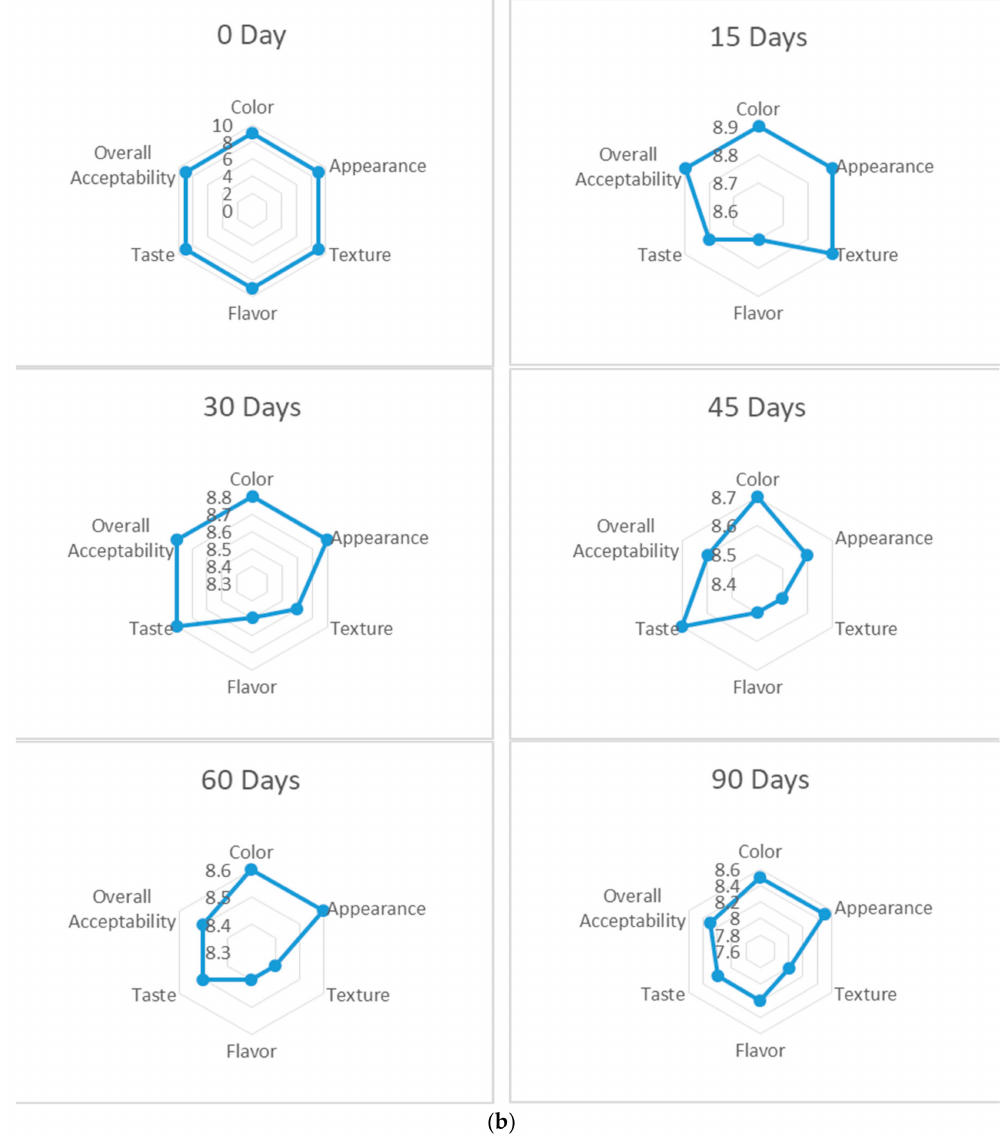
Figure 2. ( a ) Sensory profile of ready to serve beverage of Cape gooseberry during storage at Room Temperature (RT) (27 ± 2 ◦ C); ( b ) Sensory profile of ready to serve beverage of Cape gooseberry during storage at Low Temperature (LT) (4 ± 1 ◦